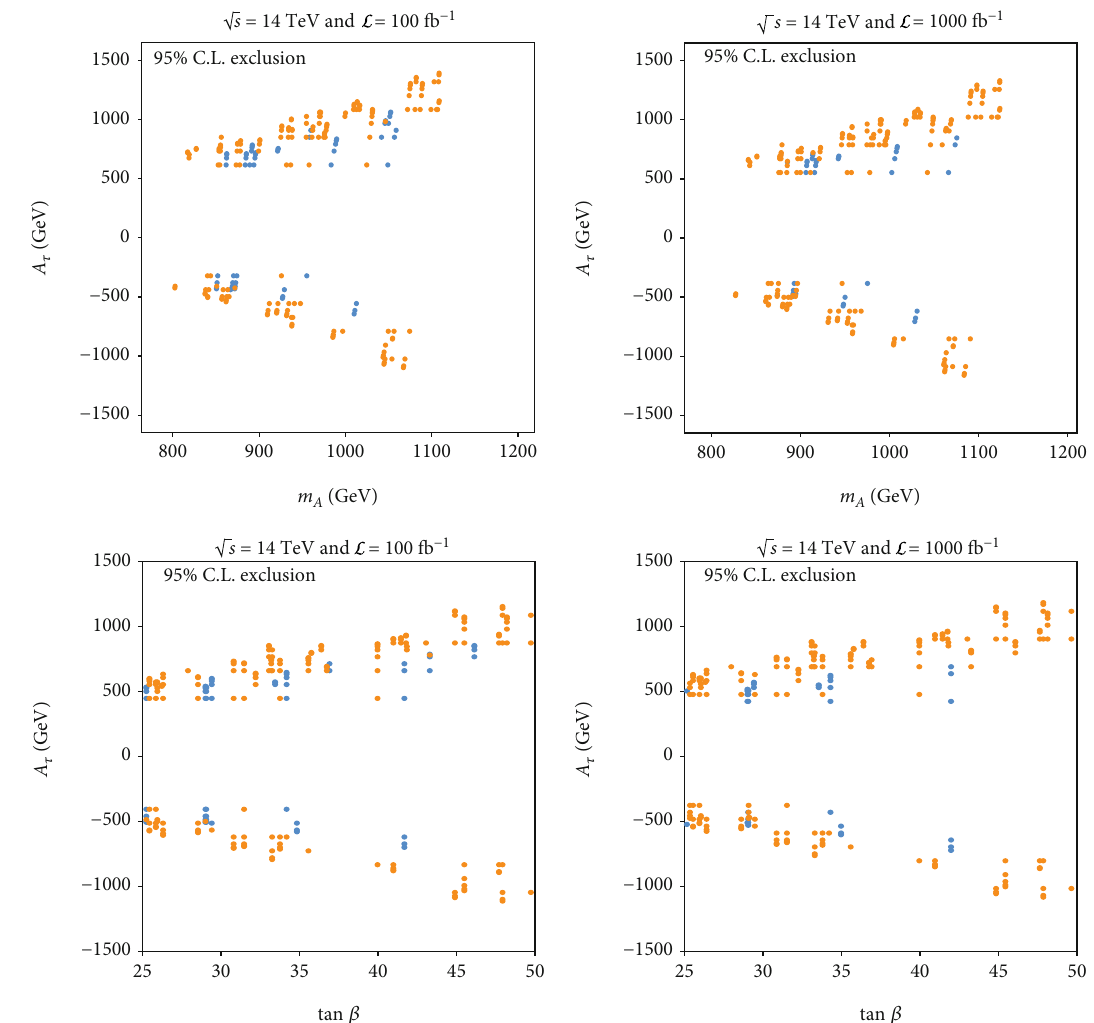
Figure 6: Potential exclusion at 95% C.L. in the ½ m ffiffi p energy of = 14 TeV and total integrated luminosities of 100fb -1 (a, c) and 1000fb -1 (b, d). Benchmarks excluded by the analysis are s shown in orange, while the allowed ones are shown in